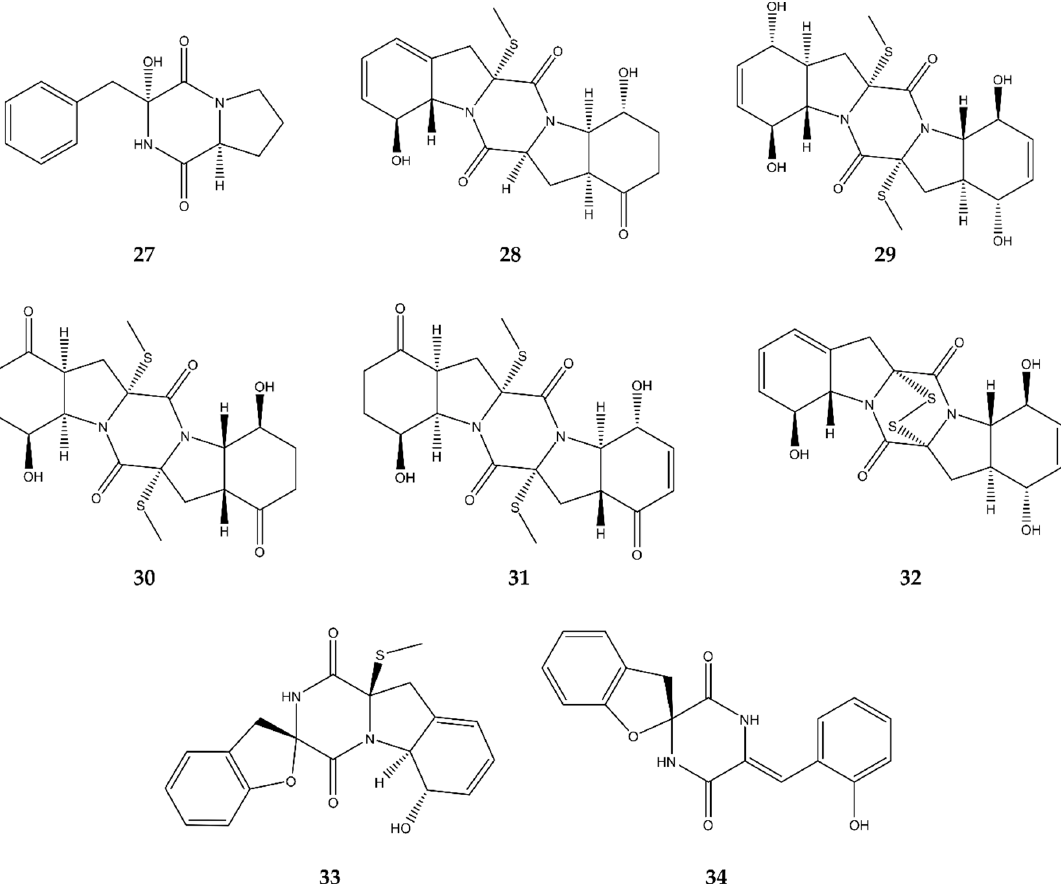
Figure 7. Overview of the different antimicrobial diketopiperazines discovered in marine fungi since